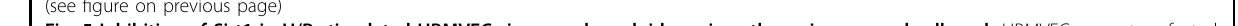
Fig. 5 Inhibition of Sirt1 in H/R-stimulated HBMVECs increased amyloidogenic pathway in neuronal cells. a – h HBMVECs were transfected with scrambled or Sirt1 siRNA for 24 h followed by exposure to 24-h H/R or normoxia, and CM samples were harvested. SH-SY5Y cells ( a ) or H4swe cells ( b – h ) were cultured with HBMVEC – CM for 24 h. The levels of neprilysin (NEP) and IDE in SH-SY5Y cells were analysed by western blotting; β -actin was used as a loading control. Representative blots from duplicated experiment are presented ( a ). In H4swe cells, the expression of full-length APP (APP-N), APP-CTF (CTF-alpha, α -C83 and CTF-beta, β -C99) and BACE1 were detected by western blotting; β -actin was used as a loading control. Representative blots are presented, and bar graph indicate the semi-quantitative levels of full-length APP, APP-CTF, APP-CTF β and BACE1, as compared to CM without H/R or Sirt1 siRNA ( b – f , n = 3, mean±SD * p < 0.05 versus without treatment by one-sample t -test, # p <0.05 versus H/R CM without treatment of Sirt1 siRNA by unpaired t- test). HBMVECs were treated with Ex527 (a Sirt1 inhibitor) at 1 μ M (Ex. 1) or 5 μ M (Ex. 5) for 24h, followed by 24-h H/R or normoxia treatment. H4swe cells were cultured with the HBMVECs NC-CM or H/R-CM for 24h. Full-length APP (APP-N) and the carboxy-terminal fragment of CTF β were detected by western blotting. Representative blots are presented ( g ), and bar graph indicate the semi-quantitative levels of CTF- β /APP ( h n = 5, mean± SD; * p < 0.05, * * p < 0.01 versus CM with normoxia without treatment of Ex527 by one-way ANOVA with multiple comparison). i – l HBMVECs were transfected with scrambled or Sirt1 siRNA ( i , j ) or treated with Ex527 ( k , l ) for 24h followed by 24-h H/R exposure. H4swe cells were cultured with each CM for 24 h. The concentrations of A β 40 and A β 42 in H4swe CM were analysed using ELISA. Data are shown as means±SD from